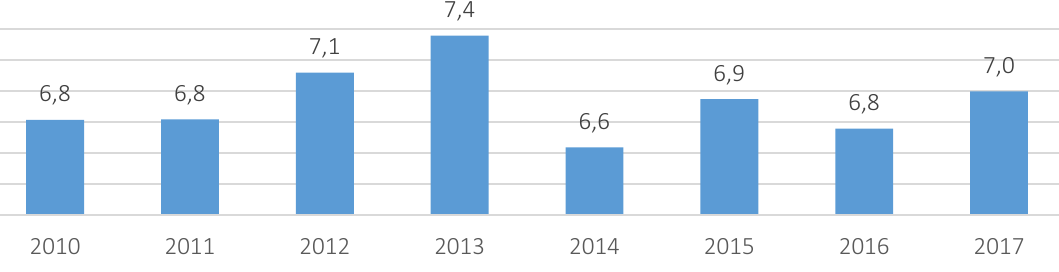
Figure 3. Current health expenditure (% of GDP), Ukraine,